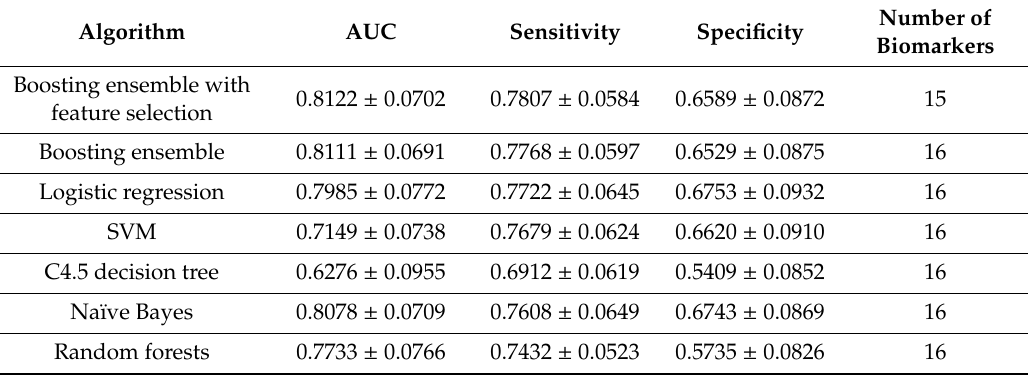
Table 2. The results of repeated 10-fold cross-validation experiments for predicting remission with genetic variants and clinical variables using the boosting ensemble model with feature selection, the boosting ensemble model, logistic regression, SVM, C4.5 decision tree, naïve Bayes, and random forests. Algorithm